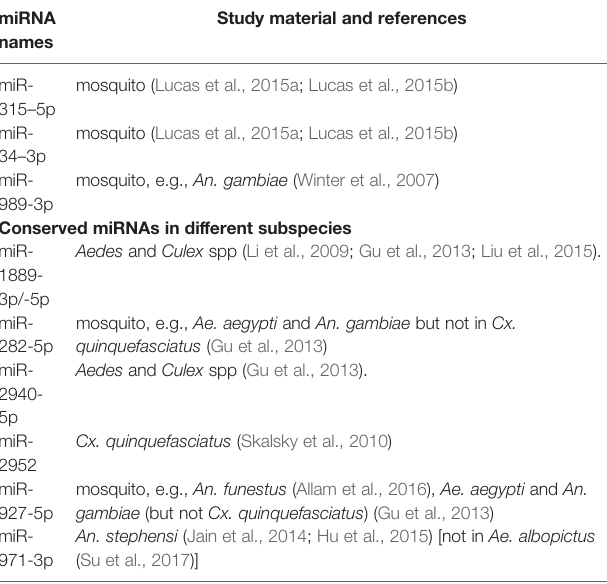
TABLE 2 | Species-speci fi c miRNAs in